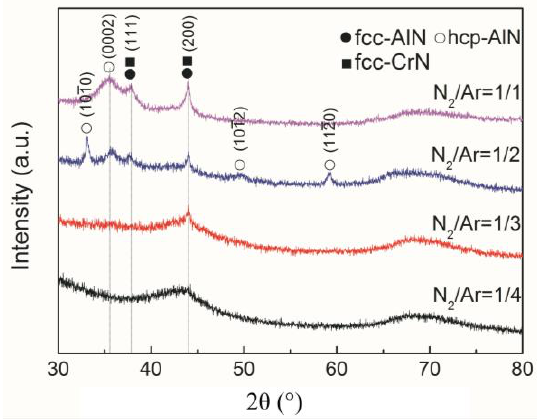
Figure 2. X-ray diffraction patterns of the AlCrSiN coatings with different N 2 /Ar flow ratio.